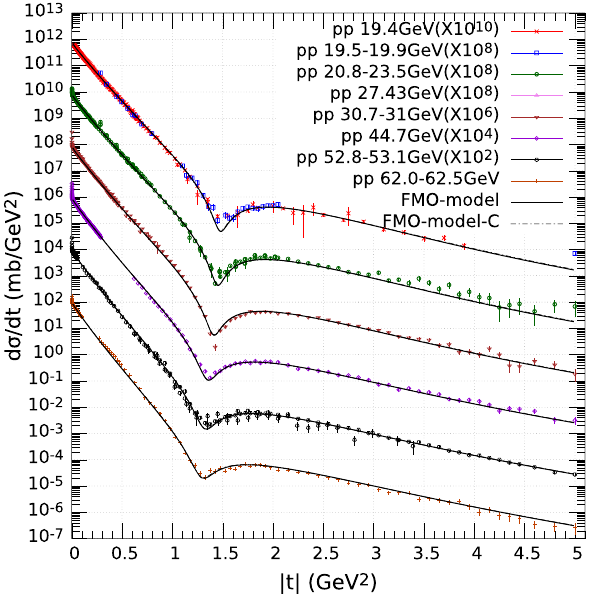
√ s from 19 GeV up to 1.96